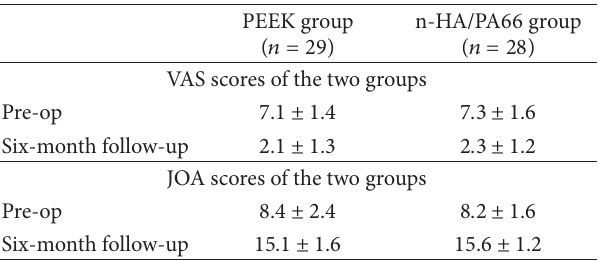
Table 2: Clinical